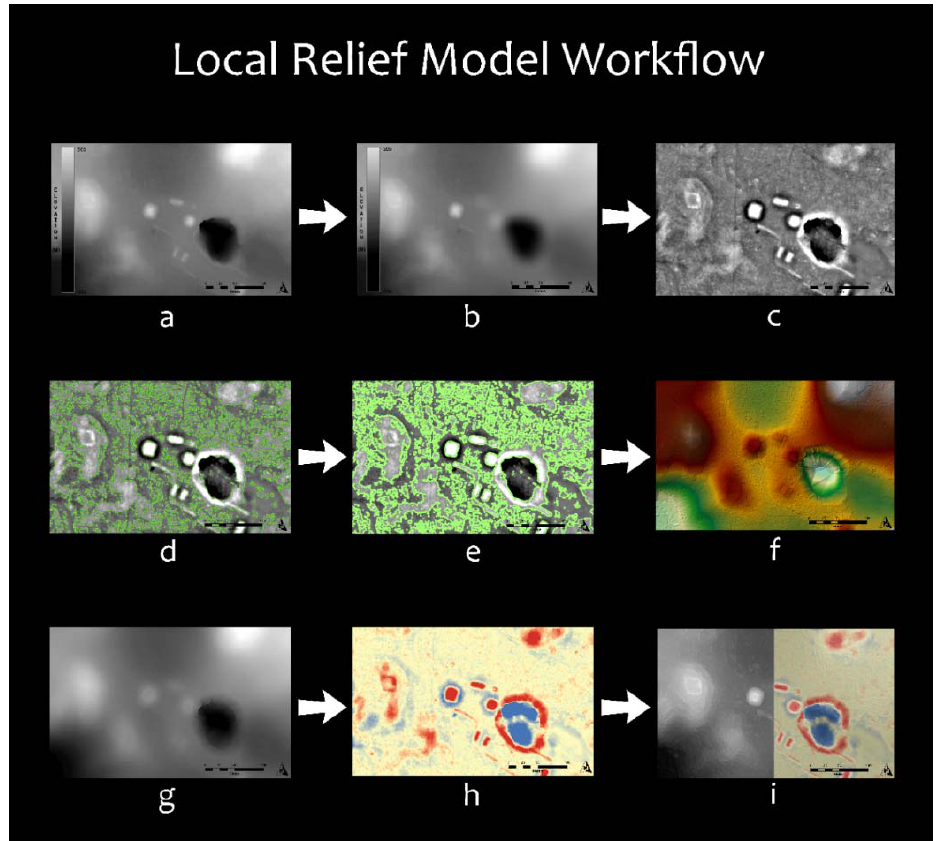
Figure 8. LRM Workflow Chart: ( a ) original 1 ‐ meter DEM of Las Cuevas, ( b ) split image of original DEM and smoothed DEM, ( c ) difference of smoothed and original DEM, ( d ) creation of contour lines, ( e ) contours converted to elevation points, ( f ) Triangulated irregular network(TIN) created from elevation points, ( g ) Digital terrain model (DTM) generated from TIN, ( h ) LRM created from subtraction of DTM from original DEM, and ( i ) split image of original DEM and LRM.